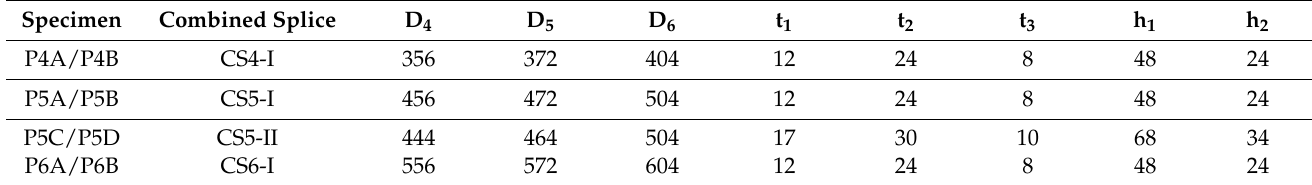
Table 4. Detailed dimension of Combined Splice (units: mm).